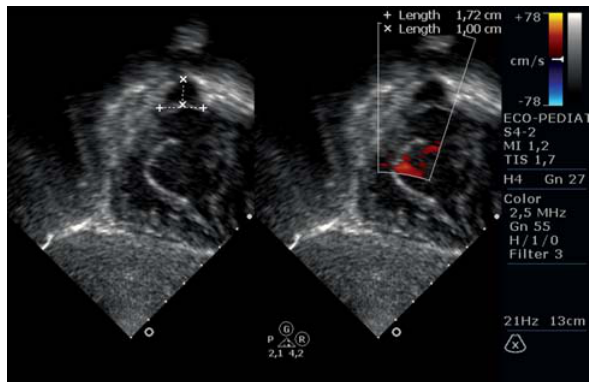
Fig. 3 – Ecocardiograma pré-operatório em corte subcostal demonstrando a via de saída do ventrículo direito, o anel valvar pulmonar e a redução de calibre no tronco pulmonar